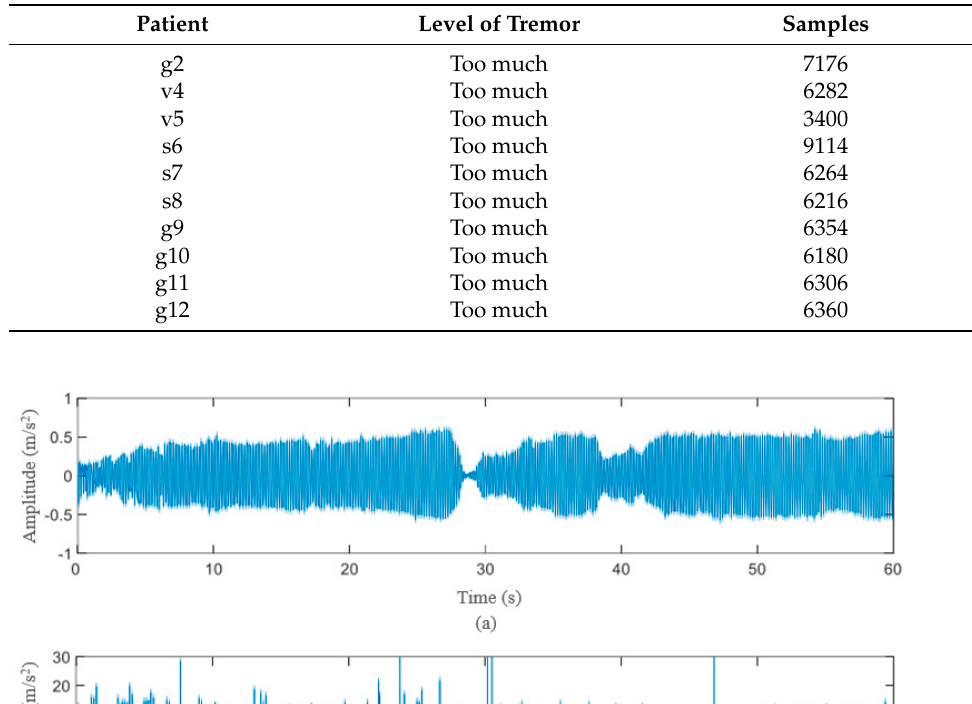
Table 2. Personal characteristics of Parkinson’s disease patients.